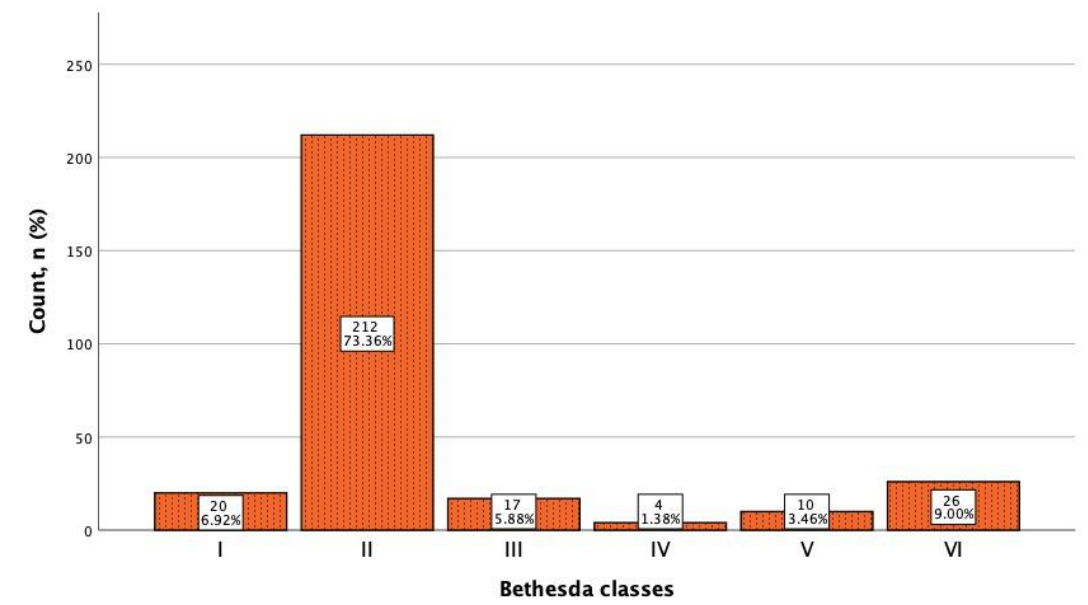
Figure 3. Incidence of cytological findings in thyroid nodules by Bethesda classes.